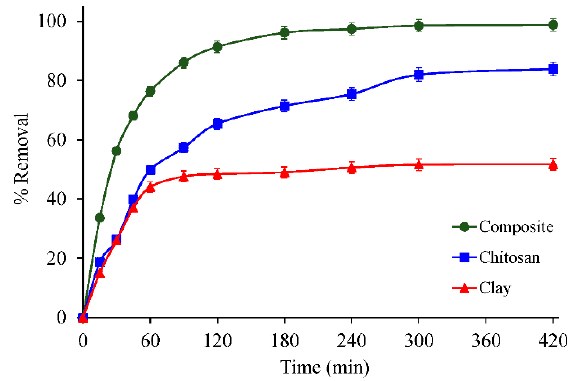
Figure 4. Dye removal as a function of the contact time on different types of adsorbent (0.6 g adsorbent dosage, pH 5.5, 100 mg L − 1 initial RR120 concentration at room temperature).